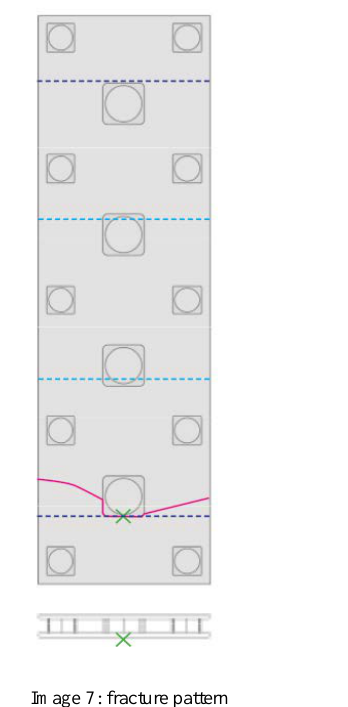
Image 7: fracture